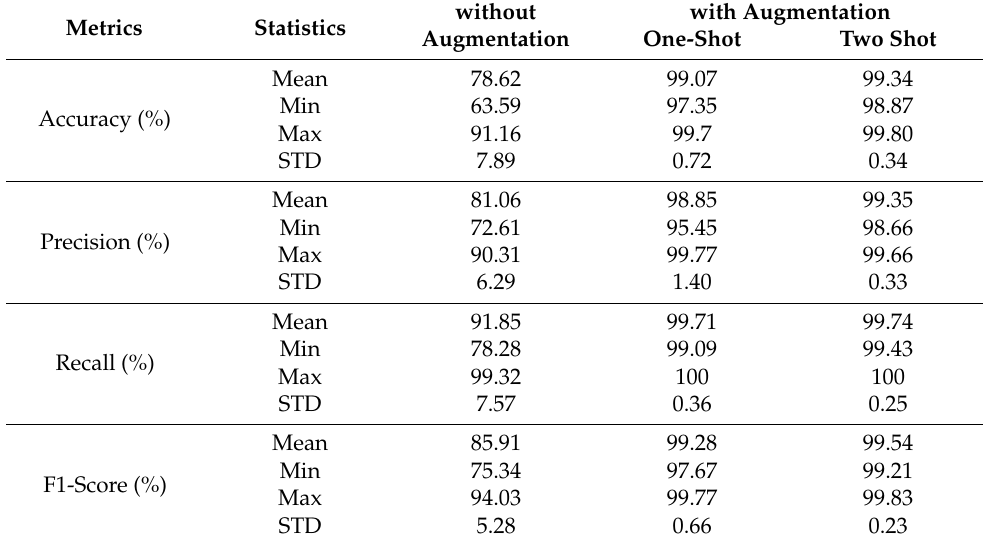
Table 1. Classification performance for baseline (without augmentation) as well as one shot and two shot learning scenarios.